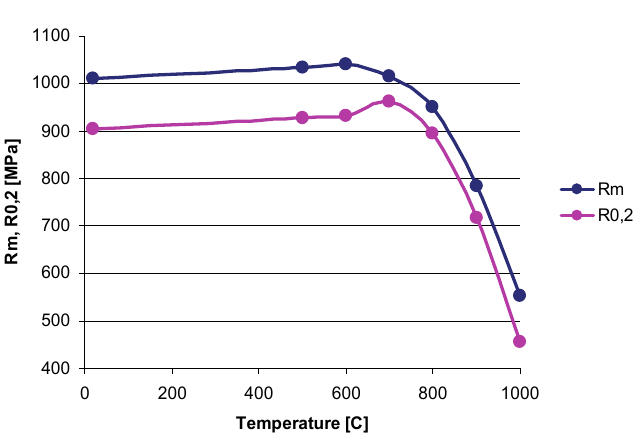
Figure 8: Mechanical properties of the casting heat-resistant alloy with nickel matrix .